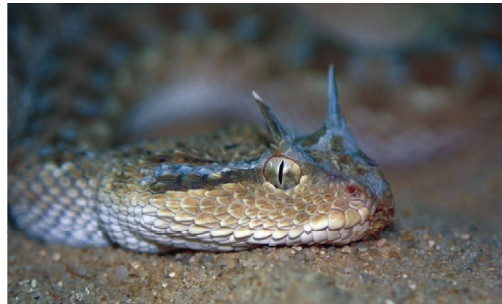
Figure 1: Cerastes gasperettii (horned) (licensed under the Creative Commons Attribution 3.0 Unported